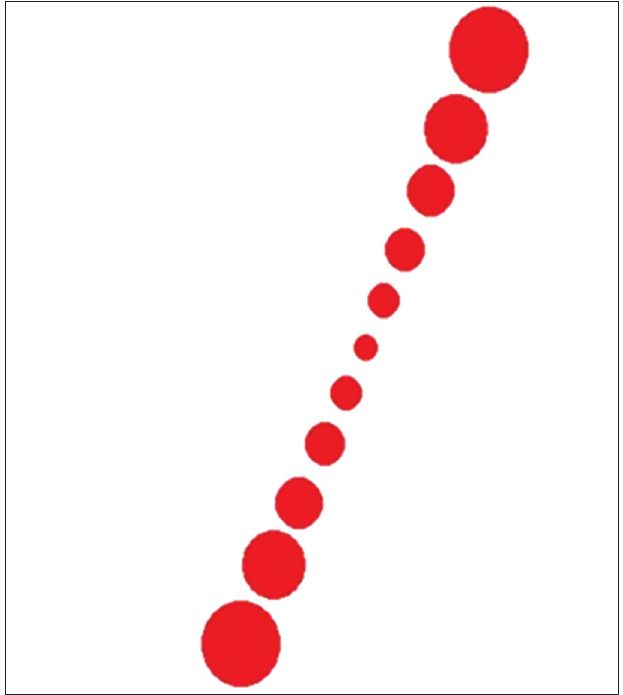
Figura 1. Tela de interface do software exibindo ambiente de esti-